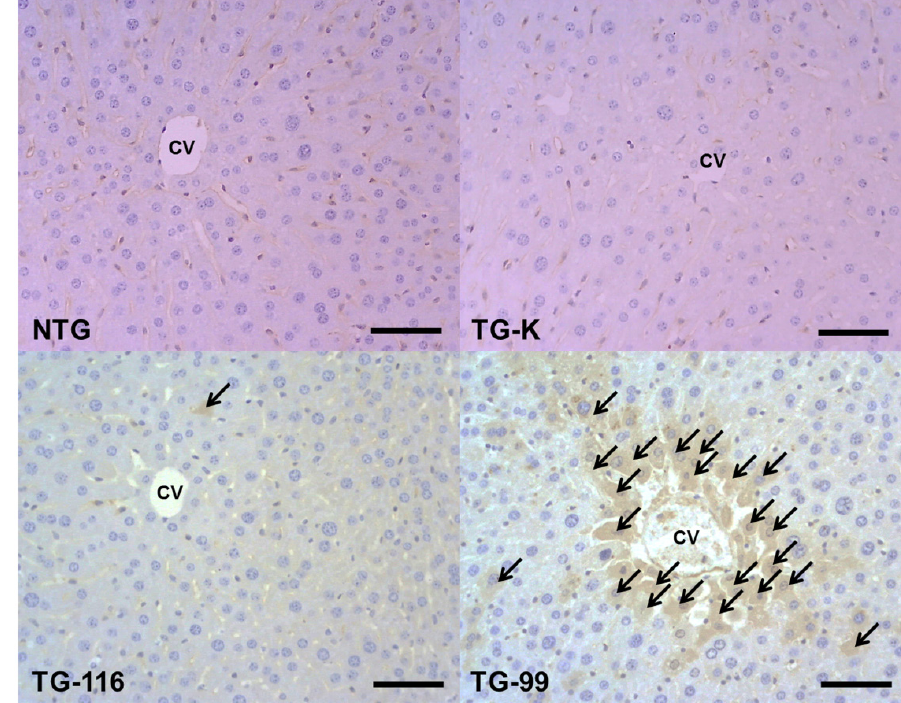
Figure 5. Immunohistochemistry staining of CK8/18. Arrows indicate CK8/18 positive cells. Scale bar = 200 μ m. CV, central